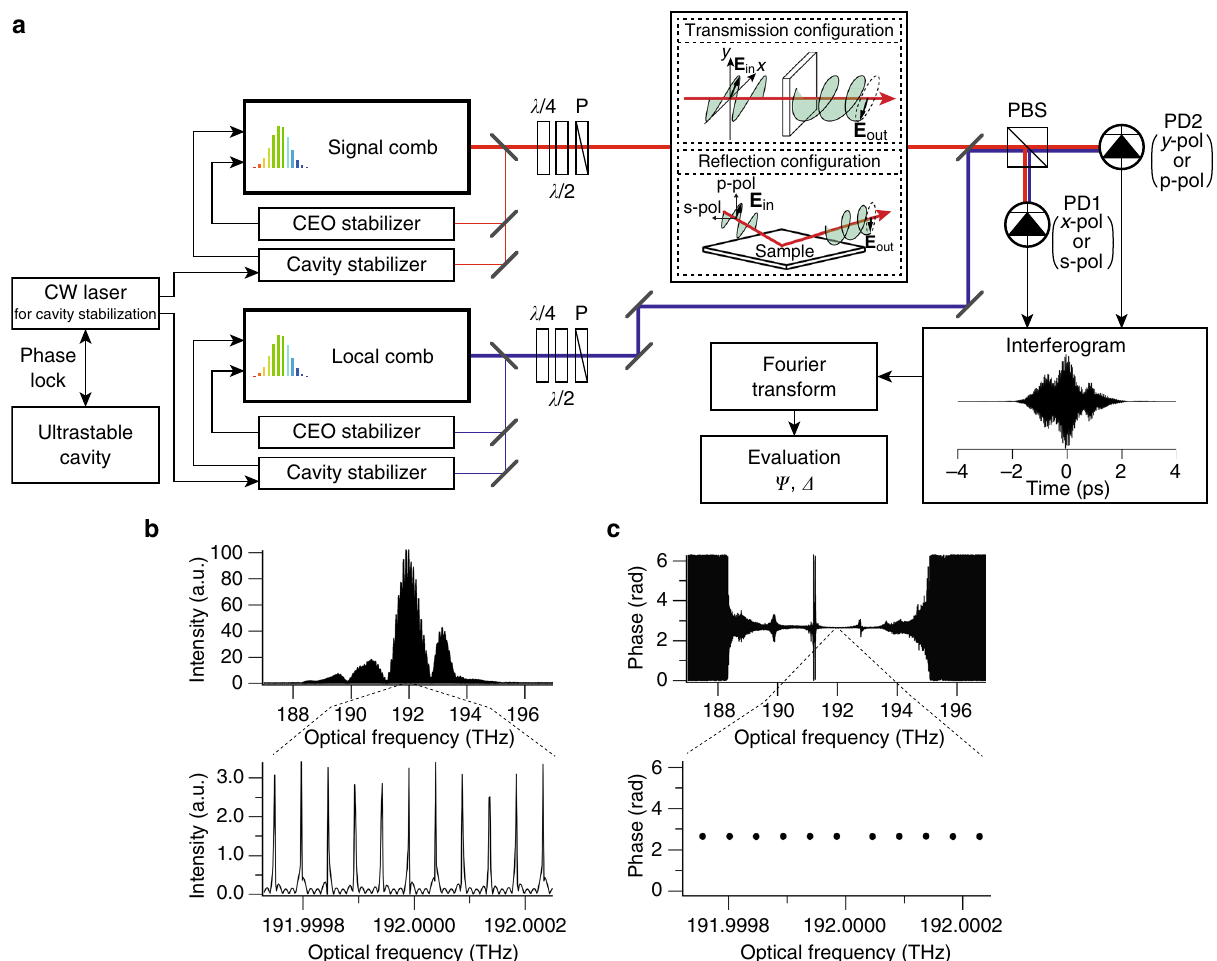
Fig. 1 Experimental setup and fundamental speci fi cations of the developed dual-comb spectroscopic ellipsometry (DCSE) system. a Con fi guration of the laser stabilization system and optical setup of the DCSE system. The components include a continuous wave (CW) laser locked to an ultra-stable cavity, a quarter-wave plate ( λ /4), a half-wave plate ( λ /2), a polarizer (P), a polarization beam splitter (PBS), and a photodetector (PD); the possible polarization components include p-polarization (p-pol), s-polarization (s-pol), x- polarization ( x- pol), and y- polarization ( y- pol) components. Fundamental speci fi cations in the form of b an amplitude spectrum of p-polarized light and c a phase difference spectrum of p-polarized and s-polarized light. The comb modes are separated by the repetition frequency of 48 MHz (3.8 × 10 − 4 nm) and can be resolved down to 1.5 MHz (1.2 × 10 − 5